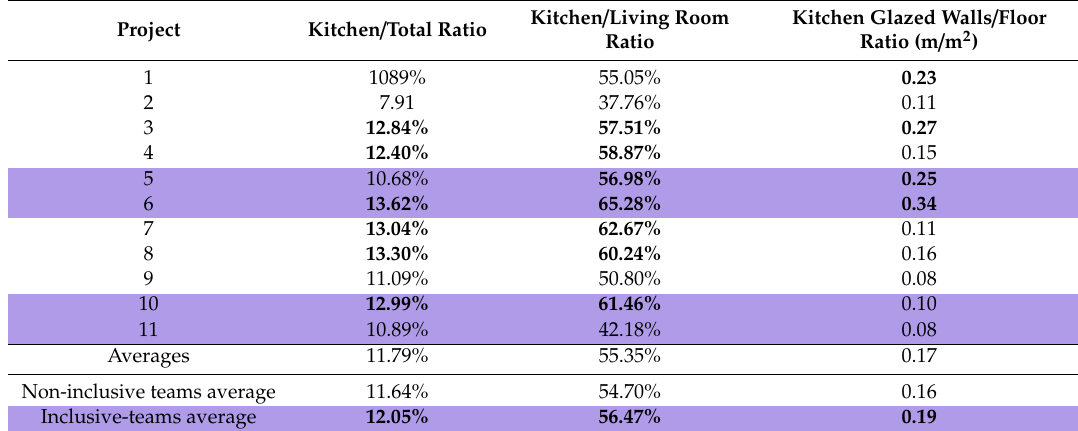
Table 1. Kitchen surface and glazed walls ratios, including averages.